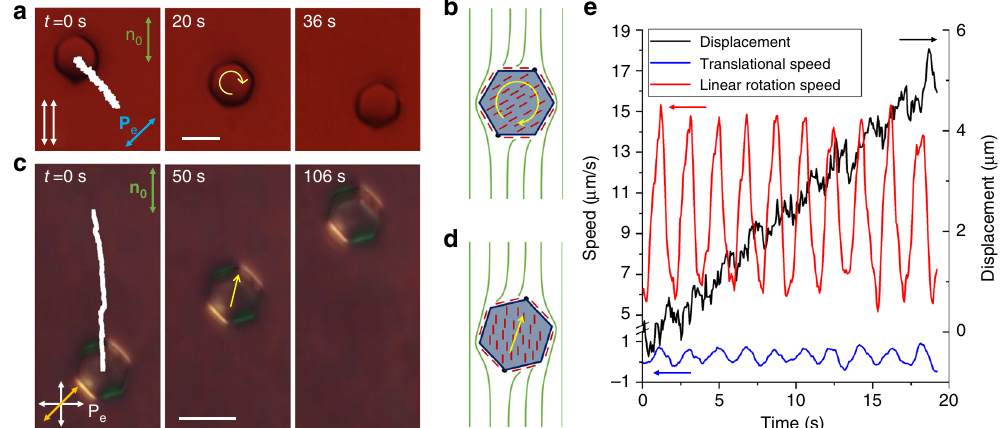
Fig. 9 Translational motion of ≈ 1 μ m thick colloidal platelets powered by light. a Snapshots of translational motion of a platelet accompanied by its spinning (Supplementary Movie 8) under blue excitation light with polarization θ ≈ 45° (blue double arrow). Elapsed time is marked on images obtained under microscope ’ s parallel polarizers shown with two adjacent white double arrows along n 0 . b Schematic of director n ( r ) (green lines) around the platelet with azobenzene molecules (red rods) on its large-area top and bottom surfaces and along the edge faces. Yellow circular arrows in a and b show direction of rotation. c Snapshots of translational motion of a platelet accompanied by periodic oscillations of orientation (Supplementary Movie 9) under polarized white light with polarization at θ ≈ 90° with respect to n 0 . The symmetry axis (yellow arrow) of the platelet tilts away from the far- fi eld director at about 13° during this motion. Images are shown for elapsed times marked on images obtained under crossed polarizers (white double arrows) with retardation plate (slow axis indicated by orange double arrow). The far- fi eld director n 0 is shown using green double arrows and scale bars are 5 µ m. d Schematic of n ( r ) and platelet with a self-assembled monolayer of azobenzene molecules corresponding to c . e Time dependence of translational displacement (black line) and speed (blue line) of the platelet shown in a . The speed of particle translation exhibits the same periodicity as the linear speed (red line) of the hexagon ’ s vertices with respect to its center, indication that the translational dynamics is directly coupled to angular